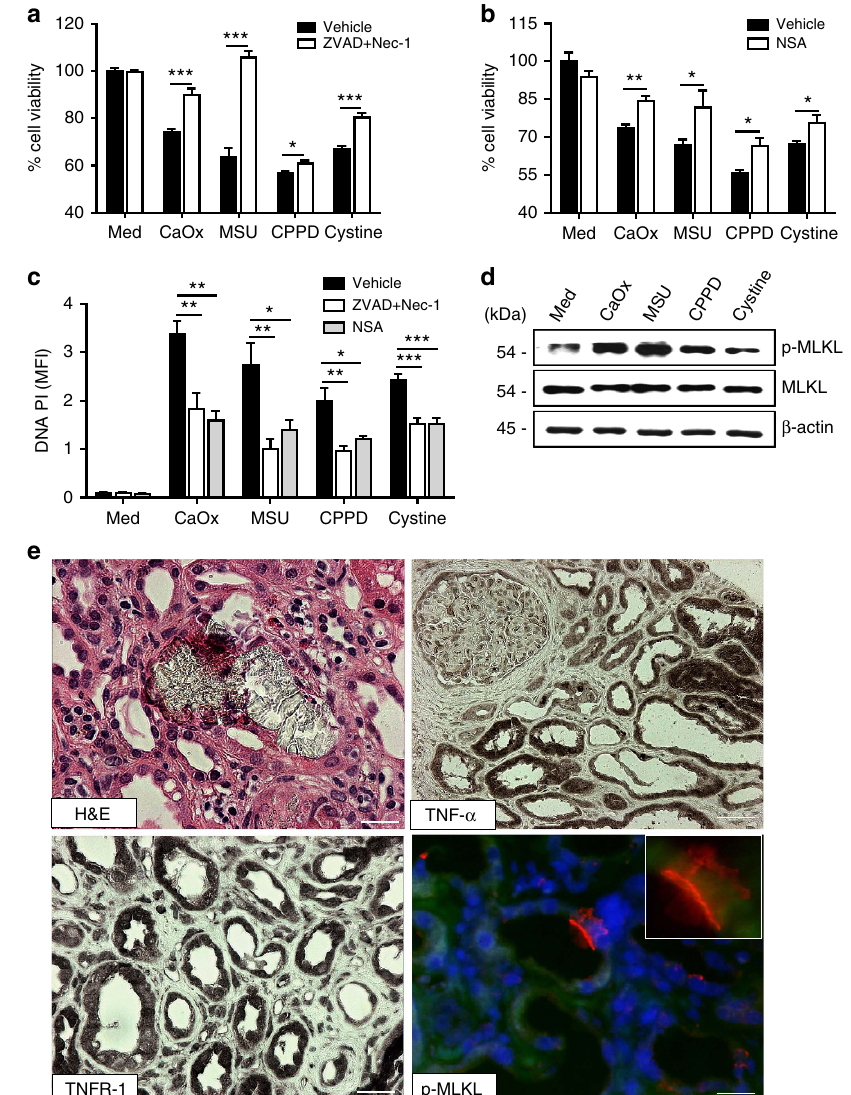
Figure 9 | Necroptosis is involved in human acute oxalate nephropathy. ( a – c ) Primary renal human progenitor cells were pretreated with either ZVAD– FMK (10 m M) and Nec-1 (100 m M) or NSA (1 m M) before being exposed to CaOx (1000 m gml (cid:3) 1 ), MSU (500 m gml (cid:3) 1 ), CPPD (500 m gml (cid:3) 1 ) and cystine (500 m gml (cid:3) 1 ). Cell viability was assessed by MTTassay ( a and b ) and cell death was assessed quantifying PI positivity ( c ) 24h later. Data are expressed as mean ± s.e.m. of three independent experiments. Baseline viability is set as 100%. Data were analysed using Student’s t -test. * P o 0.05, ** P o 0.01, *** P o 0.001 either versus vehicle control. ( d ) Primary renal human progenitor cells were stimulated with different crystals as indicated above for 18h. The expression of Phospho-mlkl and total mlkl was detected by western blot with b -actin as a loading control. ( e ) Selective cases of human oxalate crystal-related acute kidney injury were stained with PAS and for TNF- a , TNFR1 and phosphorylated MLKL. Representative images are shown at an original magnification